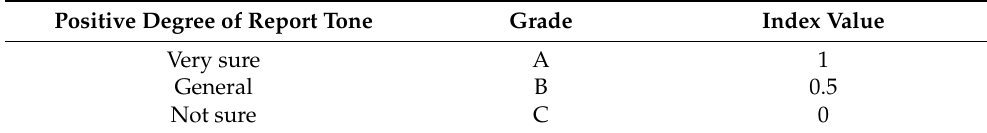
Table 1. The judgment method of the positive degree of eyewitness report tone.